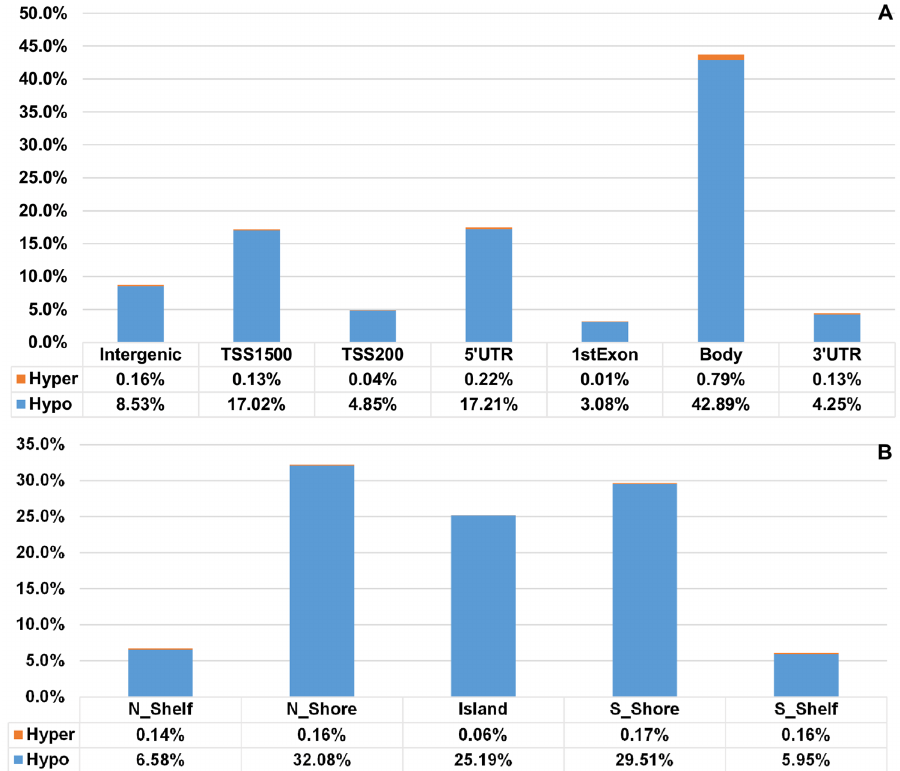
Fig 4. Distribution of differentially methylated sites according to genic location and to CpG island relation. (A) Distribution of DMS according to genic location. Relative percentages of DMS (both hypo-methylated and hyper- methylated CpG sites between ME/CFS cases and controls) are reported for each genic body location: gene regulatory elements (regulatory: TSS1500, TSS200, 5’ UTR, 3’ UTR), the coding regions of genes (gene body), as well as all Intergenic and 1st Exon gene body regions. (B) Distribution of DMS according to their location in relation to CpG islands. Relative percentages of DMS (both hypo-methylated and hyper-methylated) are reported. CpG islands with clustered CpG sites; 2 kb upstream and downstream of CpG islands (N, S Shores); 2 kb upstream and downstream of CpG shores (N, S Shelves).